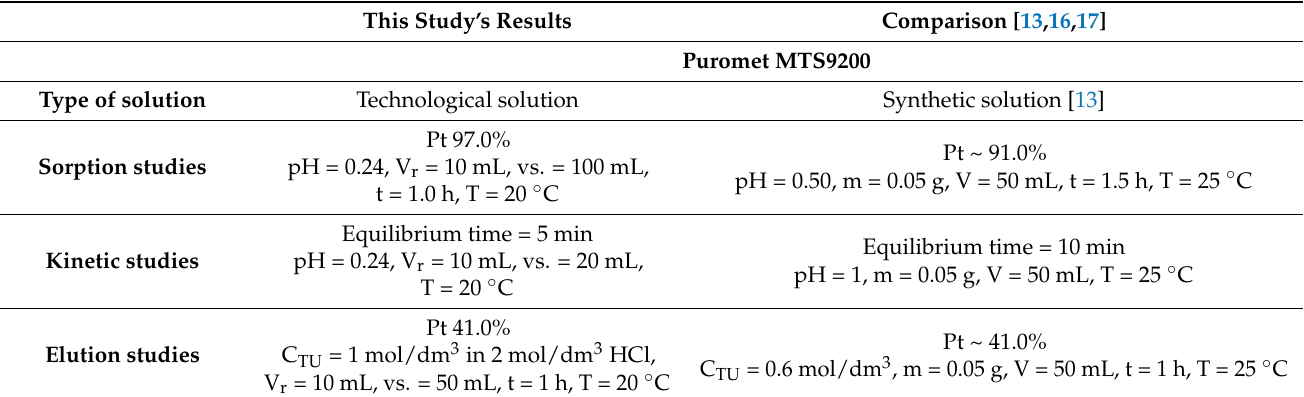
Figure 6. The dependence of noble metal cementation yields [%] on the amount of zinc added to the solution [g].